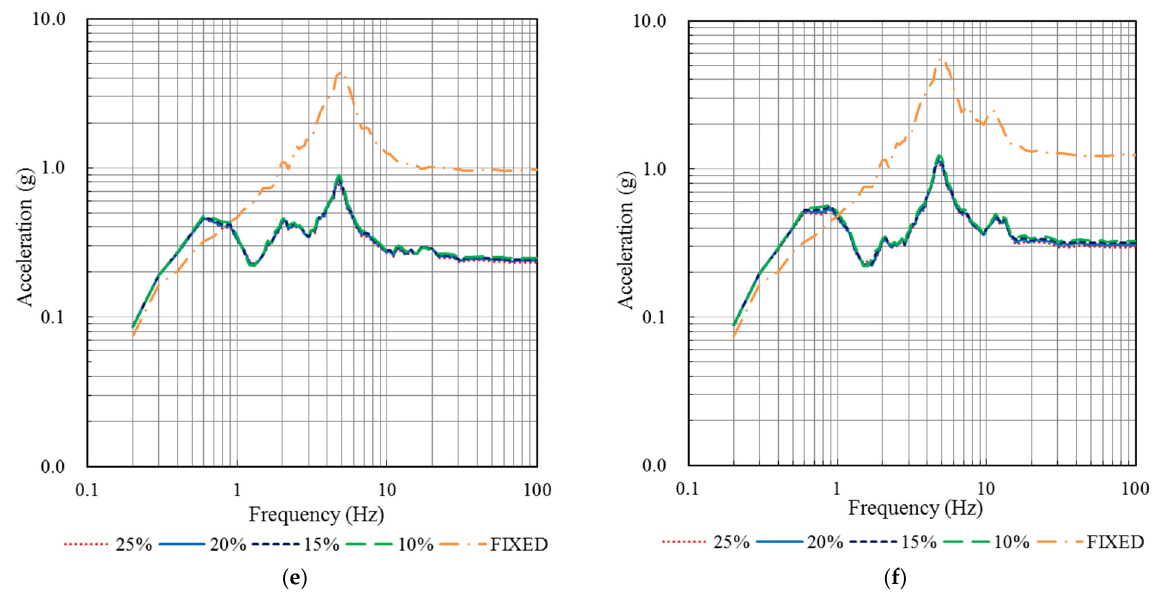
Figure 9. Comparison of the FRS of containment and internal structures in the horizontal direction. ( a ) NODE 12_X; ( b ) NODE 13_X; ( c ) NODE 12_Y; ( d ) NODE 13_Y; ( e ) NODE 3_X; ( f ) NODE 4_X. Table 3. Comparison of peak values and ZPA of the FRS in the horizontal direction.